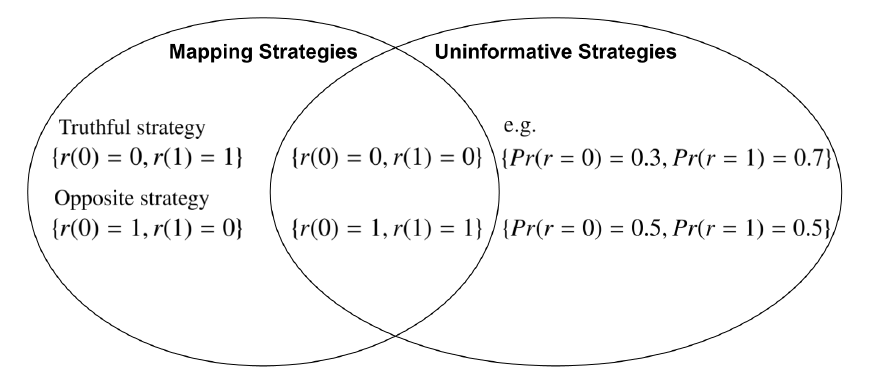
Fig. 2. Nodes (curators) can use either mapping or uninformative strategies for reporting. The strategy of always reporting 0 or always reporting 1 can be classified as both mapping and uninformative